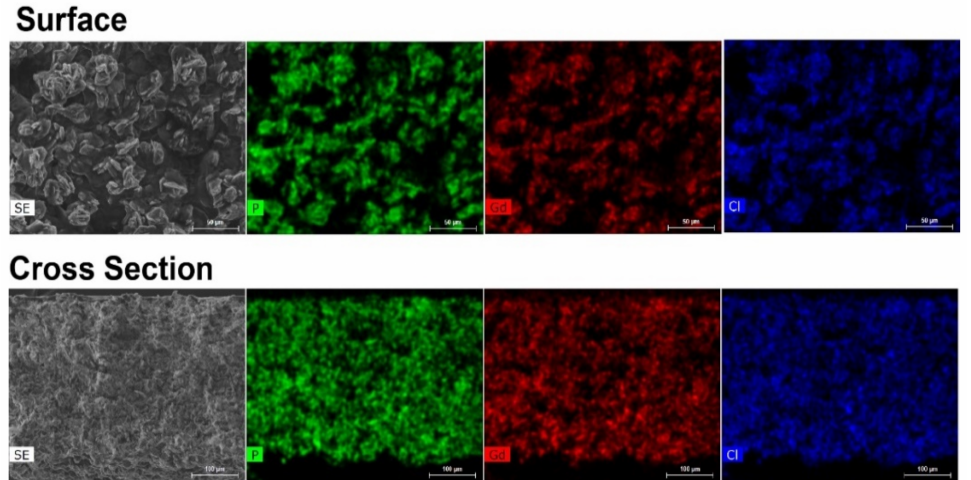
Figure 3. EDS mapping of UAV-59@PMMA of the membrane surface and of a cross section, showing a uniform distribution of the coordination polymer throughout the polymeric